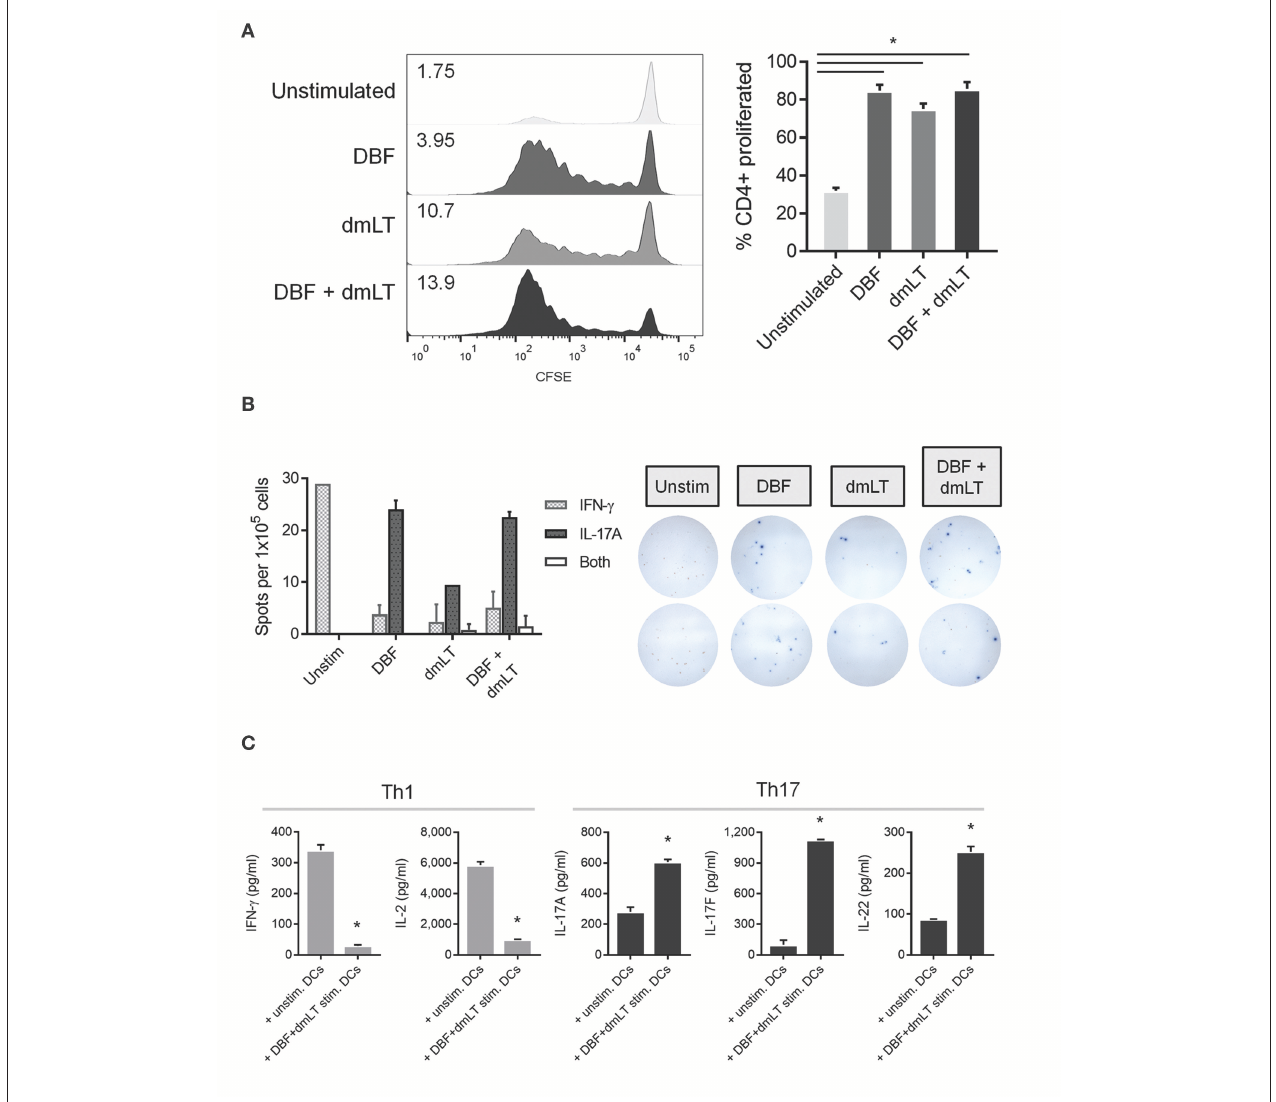
FIGURE 5 | Co-culture of pre-treated DCs and isolated spleen T helper cells. DC populations exposed to PBS, DBF, dmLT and the combination DBF + dmLT for 48h were then co-cultured for 7 days with CD4 + cells isolated from spleens of mice immunized with DBF + dmLT intranasally. (A) Proliferation of CD4 + cells was analyzed by CFSE fluorescence patterns. Stacked histograms show the differential distributions of fluorescence intensity. Numbers present inside the grids indicate the proliferation index of each population (proliferation index = average number of cell divisions during treatment). Bar graph shows the percentage of cells that proliferated after day 0. All antigen-treated DC co-cultures had significantly higher percentages of cell proliferation. Each bar represents the mean and SEM of duplicate biological samples. (B) CD4 + cells were sorted post-culture and cytokine-secreting cells determined by ELISpot. IFN- γ , IL-17, or double IFN- γ + IL-17 spot forming cells (SFC) were counted and bar graphs show the differential amounts present for each treatment. Representative well images are included, red spots are IFN- γ SFCs and blue spots are IL-17 SFCs. Each bar represents the mean and SD of duplicate biological samples. (C) Cytokine secretion by co-cultured cells was measured as described in methods. Each bar represents the mean and SD of duplicate biological samples. Statistical significance was analyzed with an ordinary one-way ANOVA with a Tukey post-hoc test. All comparisons tested with an α value of 0.05. * p <